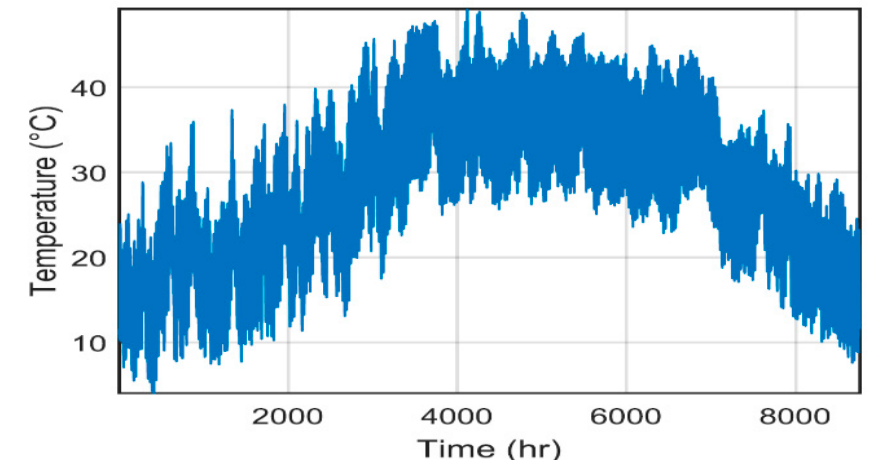
Appl. Sci. 2020 , 10 , x FOR PEER REVIEW Figure 6. Solar irradiation over the studied region. Figure 6. Solar irradiation over the studied region.